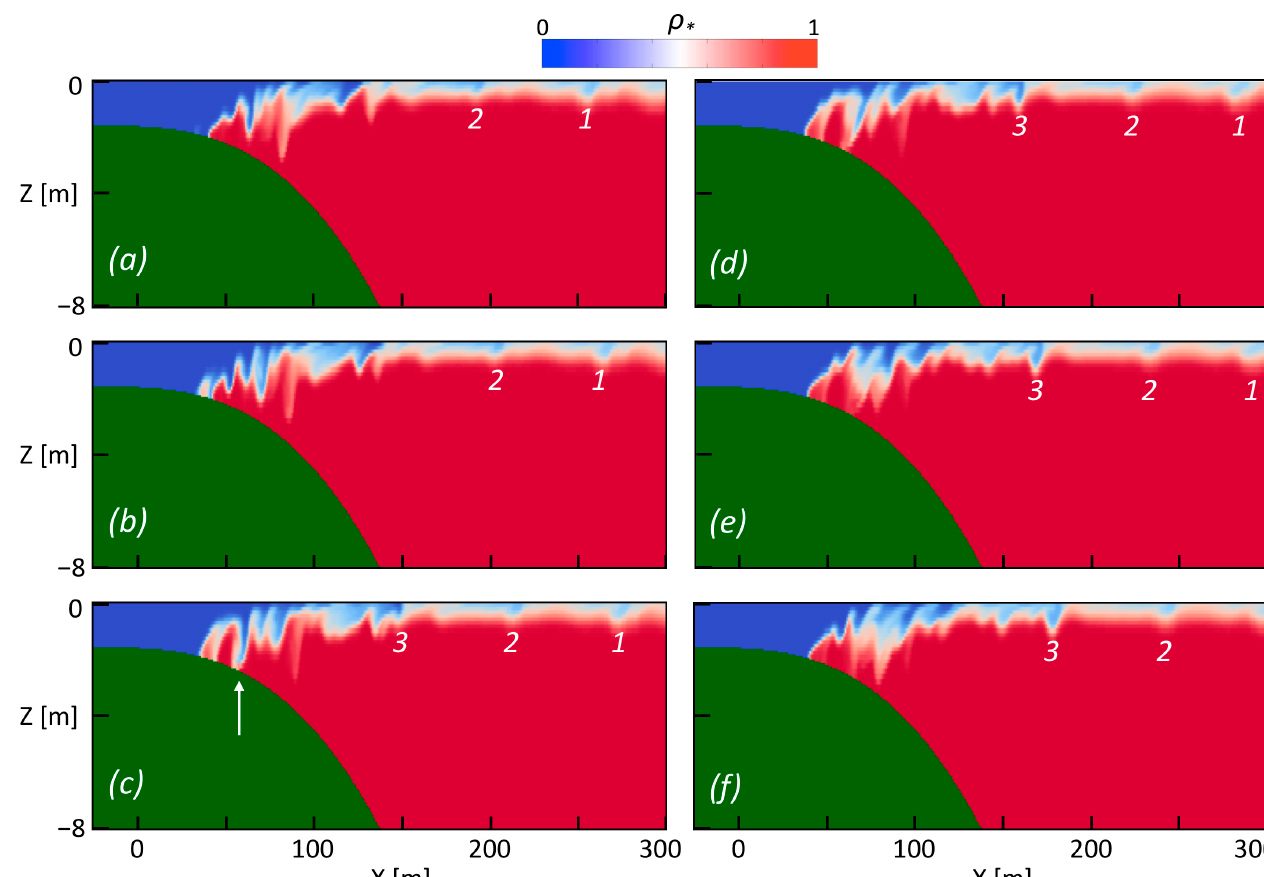
Figure 6. Centerline ( x - z ) section of normalized density, shown at 10-s intervals: ( a ) t = 1610 s; ( b ) t = 1620 s; ( c ) t = 1630 s; ( d ) t = 1640 s; ( e ) t = 1650 s; ( f ) t = 1660 s. Note that only the plume’s inner portion ( x < 300 m) is being shown. Features 1–3 correspond to evolving ring features. Arrow in panel c points to a localized, near-bottom penetration of plume water.